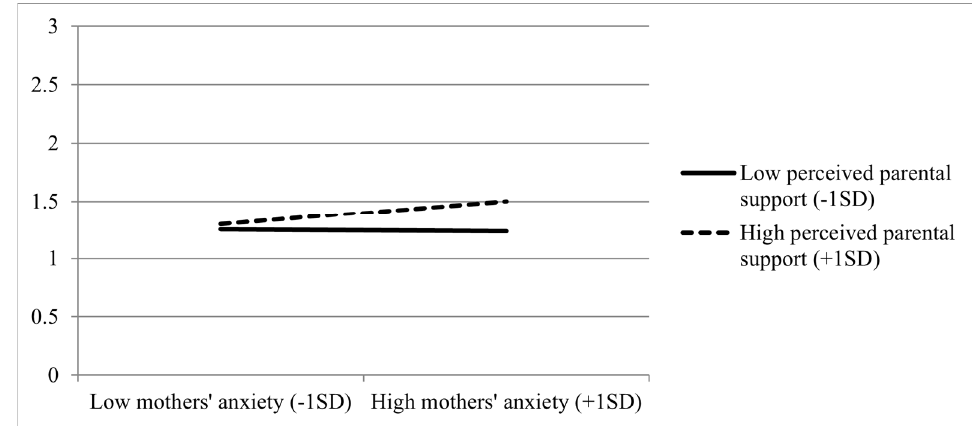
Figure 1. Children’s stress as a function of perceived parental support and mothers’ anxiety ( N = 395 families, i.e., N children = 414, N mothers = 395).